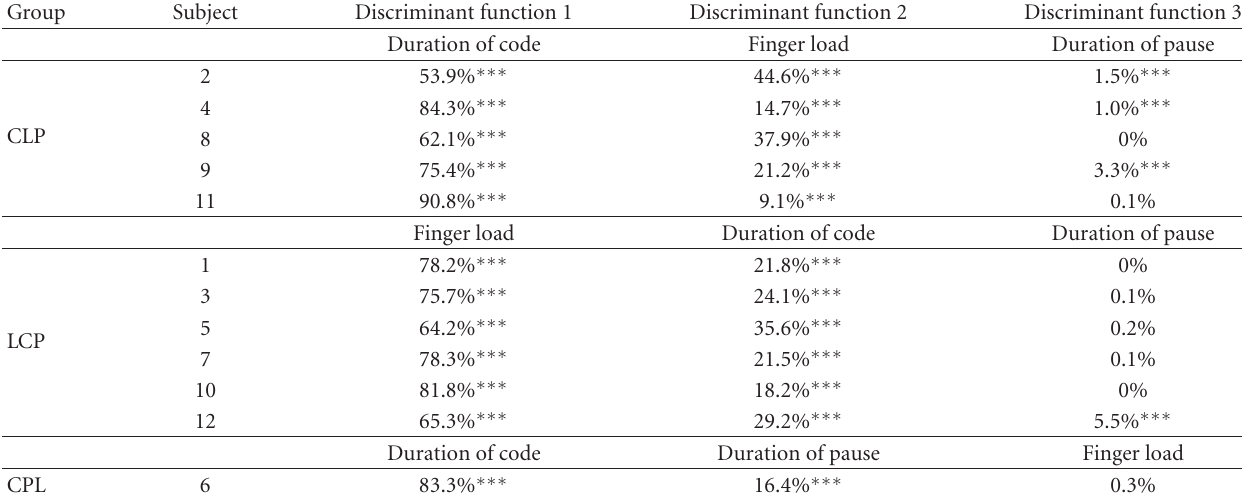
Table 9: Represented variables for discriminant functions, contribution ratios, and significance probability ( ∗∗∗ P < . 001 ). Group